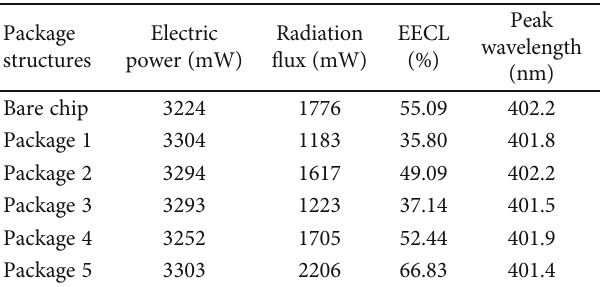
Table 1: Radiation fl ux and electrooptical conversion e ffi ciency of di ff erent package